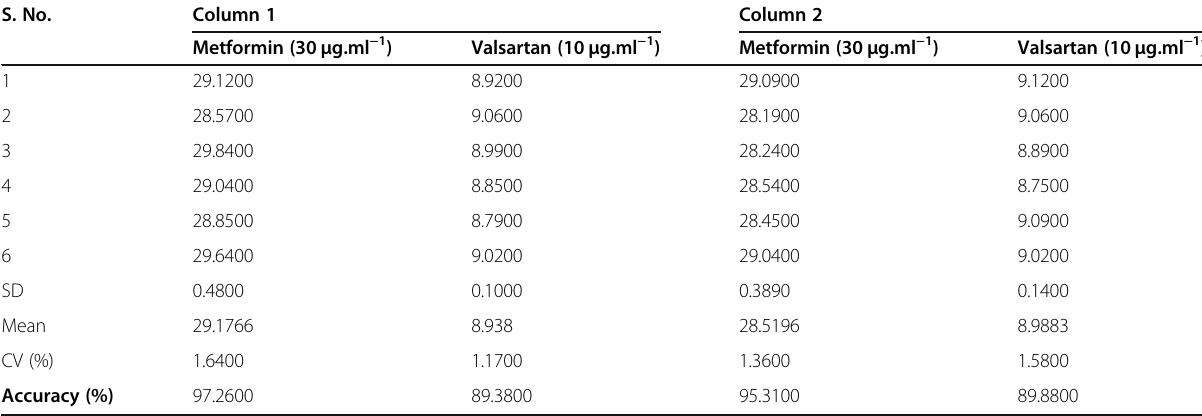
Table 6 Robustness: metformin-valsartan S. No.